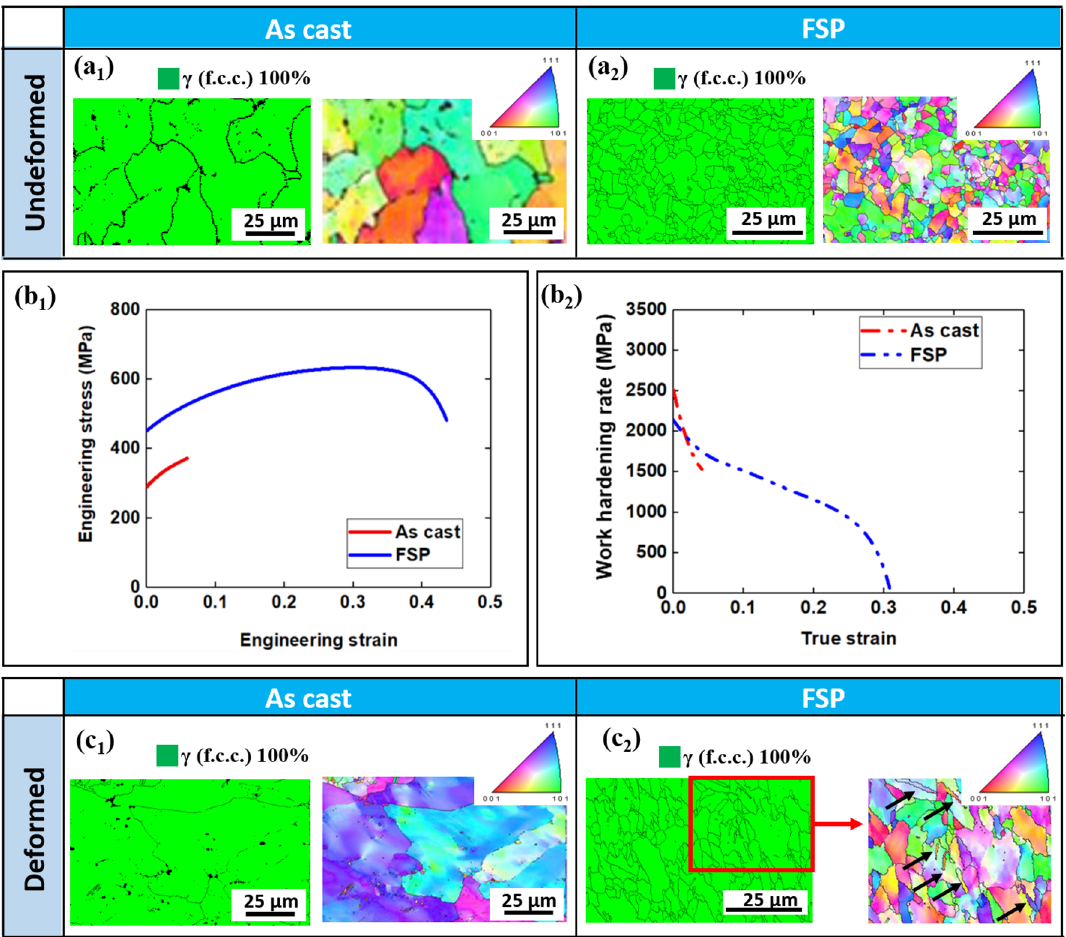
Figure 1. EBSD phase map and IPF map of ( a 1 ) as-cast and ( a 2 ) FSP specimen in undeformed condition; ( b 1 ) engineering strain–stress and ( b 2 ) work hardening rate curves of as-cast and FSP specimens under quasi static tensile testing load; EBSD phase map and IPF map of ( c 1 ) as-cast and ( c 2 ) FSP specimens in deformed condition. Note that deformational twins are labelled by black arrows in ( c 2